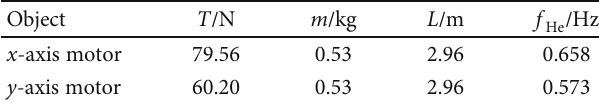
Table 3: Suspension frequency of zero gravity simulator.